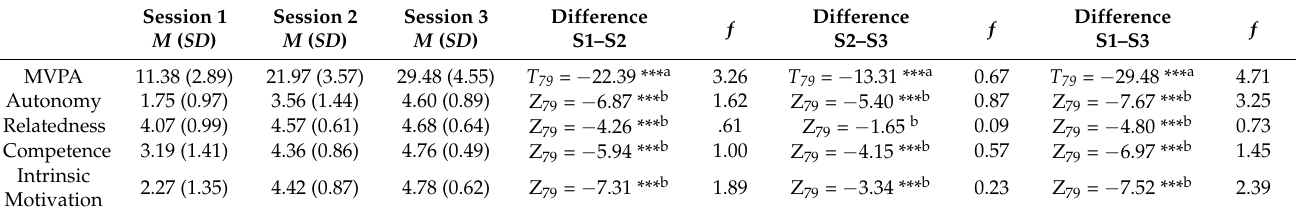
Table 2. Means, standard deviations, and differences in MVPA, basic psychological needs, and in- trinsic motivation in sessions one (low autonomy-supportive teaching), two (intermediate auton- omy-supportive teaching), and three (high autonomy-supportive teaching).